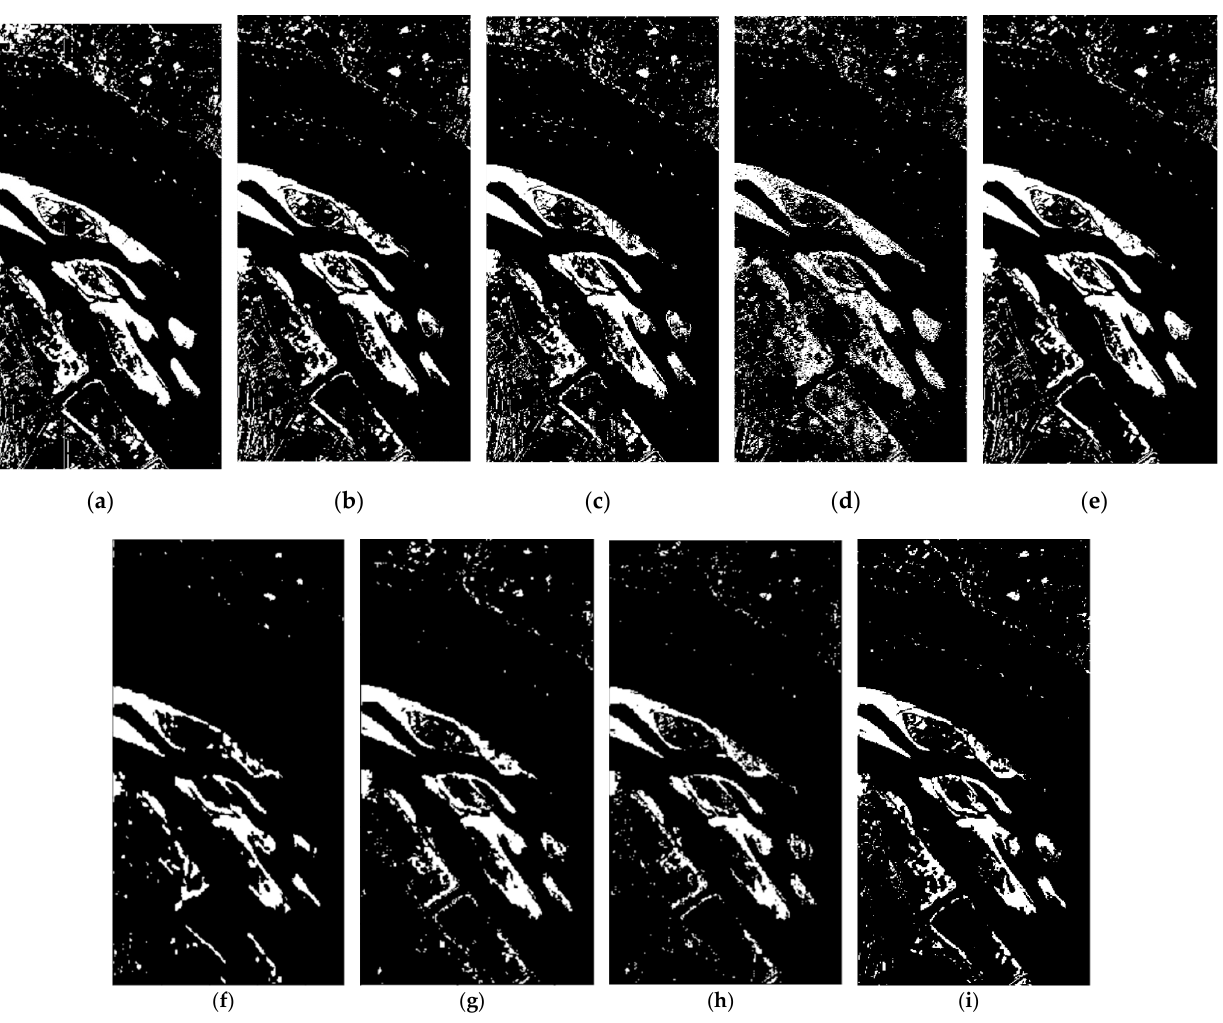
Figure 4. Change detection (CD) result on Farmland. ( a ) Change vector analysis (CVA) [14] ( b ) Principal component analysis CVA (PCACVA) [25] ( c ) Support vector machine (SVM) [19] ( d ) Patch-based convolution neural network (PBCNN) [56] ( e ) GETNET [37] ( f ) Hybrid spectral CNN